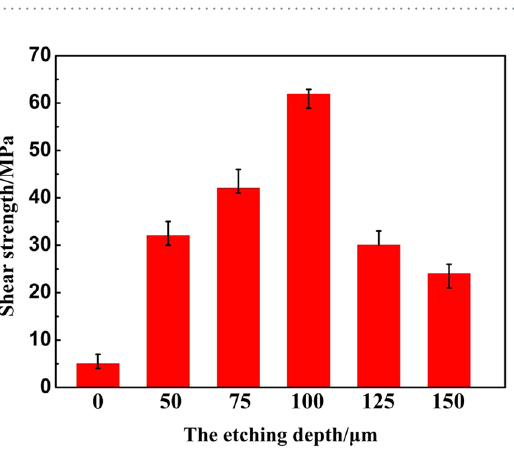
Figure 11. SEM images of ( a ) 0 μ m@E-SiO 2f /SiO 2 -Nb, ( b ) 50 μ m@E-SiO 2f /SiO 2 -Nb, ( c ) 75 μ m@E-SiO 2f / SiO